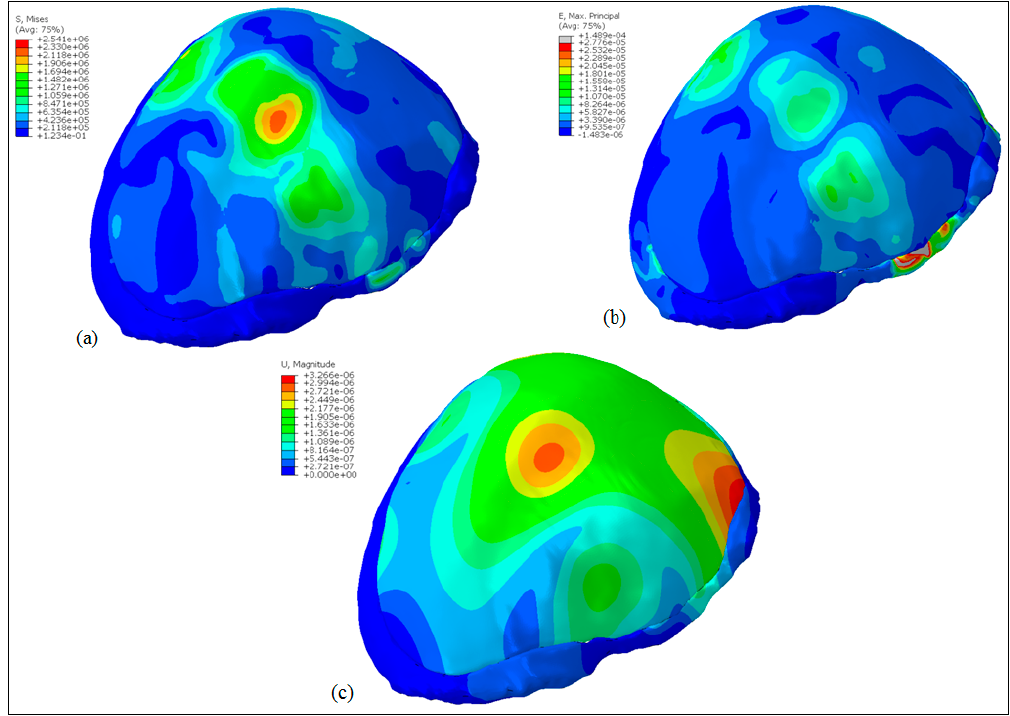
Figure 8. FEA Results illustrating: ( a ) stress distribution; ( b ) strain distribution; ( c ) maximum